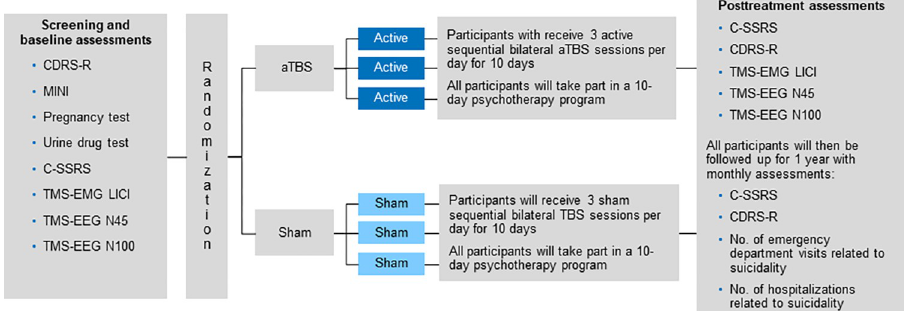
Fig 2. Study schema. Legend . aTBS, accelerated theta burst stimulation; CDRS-R, Children’s Depression Rating Scale Revised; C-SSRS, Columbia–Suicide Severity Rating Scale; LICI, long-interval intracortical inhibition; MINI, Mini- International Neuropsychiatric Interview; N45, TMS-EEG evoked potential at 45 milliseconds; N100, TMS-EEG evoked potential at 100 milliseconds; TBS, theta burst stimulation; TMS-EEG, transcranial magnetic stimulation and electroencephalography; TMS-EMG, transcranial magnetic stimulation and electromyography. Additional screening assessments (Table 2) include the Transcranial Magnetic Stimulation Safety Screen [69], Antidepressant Treatment History Form [70], Pubertal Development Scale [71], Mini-International Neuropsychiatric Interview for Children and Adolescents (MINI-KID) for participants aged 12 to 17 years [72] or the Mini-International Neuropsychiatric Interview for participants aged 18 years [73], Young Mania Rating Scale [74], Children’s Depression Rating Scale Revised (CDRS-R) [75], C-SSRS [68], Beck Depression Interview-II [76], and Clinical Global Impressions–Severity Scale [77]. Also discussed and noted at the screening visit are concurrent use of medications, adverse events (AEs), serious AEs (SAEs), the case report form (CRF), and concurrent psychotherapy. The screening visit can occur on the same day or across 2 consecutive days depending on participant